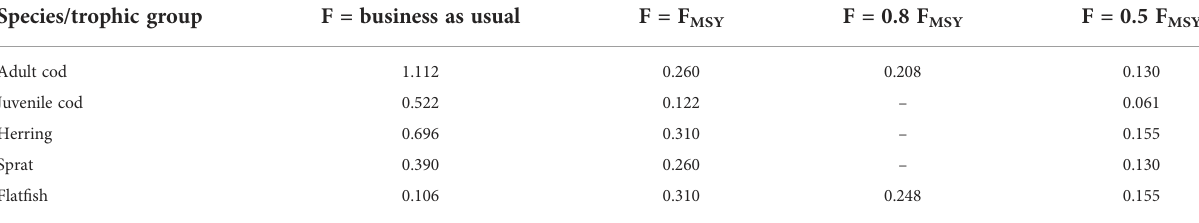
TABLE 2 Fishing mortality (F) values employed to simulate management scenarios. Species/trophic